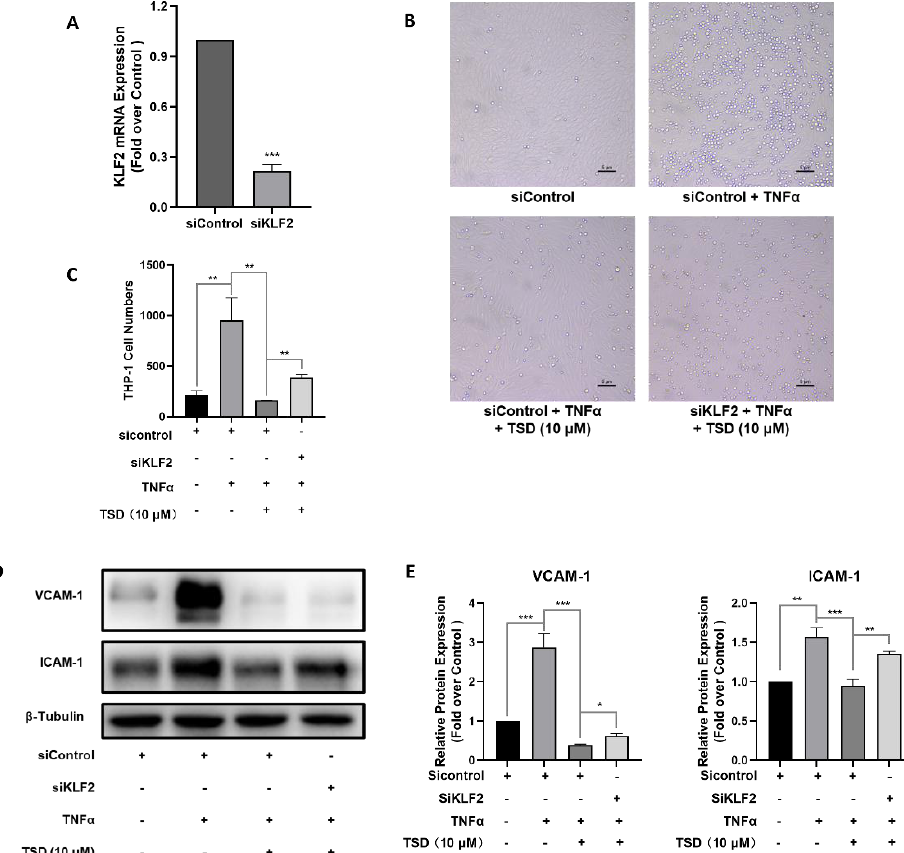
Figure 3. TSD exerts an anti-inflammatory effect dependent on KLF2. ( A – E ) Levels of KLF2 mRNA ( A ), representative monocyte adhesion images ( B ), quantification of monocyte adhesion in HUVECs ( C ), representative western blots ( D ), and quantification of protein expression of VCAM-1 and ICAM-1 ( E ) after treatment with siControl, KLF2 siRNA (siKLF2), or TSD. HUVECs were cultured in 6-well plates and were transfected with siControl or siKLF2 for 6 h. Then, the medium was replaced with endothelial cell medium and incubated for another 18 h. The cells were then treated with or without TSD (10 µ M) for 18 h, followed by 10 ng/mL TNF α for 6 h. Monocyte adhesion assays and western blot analysis were performed, as described in the Methods section. A representative image of each group is shown. The protein levels were normalized to β -tubulin. Values are represented as the mean ± SEM; n = 3; Student’s t test ( A ) or one-way ANOVA ( C , E ) was used for analysis. * p < 0.05, ** p < 0.001, *** p < 0.0001.